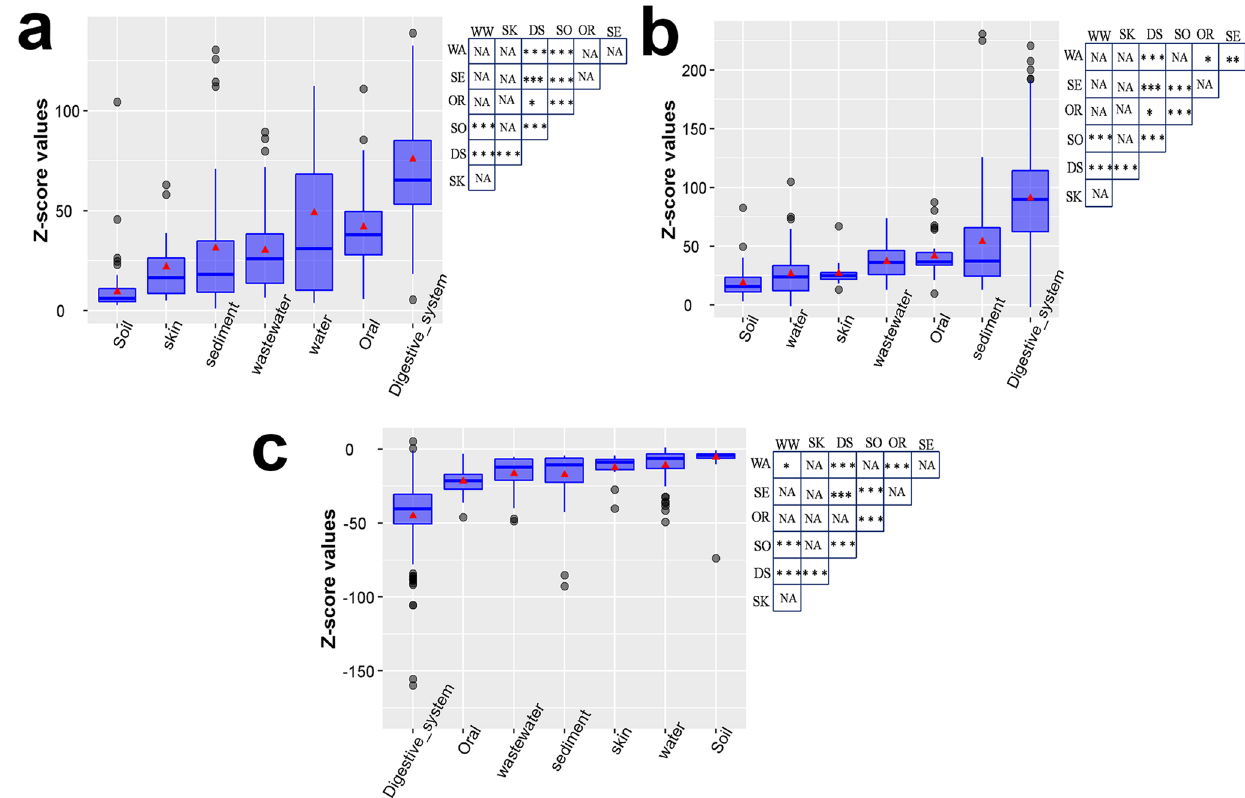
Fig. 4 Average Z-score for CAI, ENC, and DCBS values of samples from seven selected habitats. This fi gure shows the Z-scores calculated for three codon usage indices (CAI, ENC, and DCBS) of samples from each selected biome in the form of box plots. Panels a , b , and c represent Z-scores for CAI, DCBS, and ENC values respectively. Z-score values were calculated comparing average CAI/EN/DCBS values of real and random sequences of each sample. Each box represents Z-scores of samples derived from a speci fi c habitat. Horizontal line within a box represents the median value, whereas its upper and lower edges represent 25% and 75% of the data, respectively. The average of Z-scores of all samples from each habitat is shown with a red triangle. In each panel, niches were arranged from lower to higher average values of Z-scores. Statistical signi fi cance for pairwise comparison of average values (of codon usage indices) among the habitats was shown in adjacent panels. P -values were calculated by Wilcoxon signed-rank test and adjusted for multiple comparisons using Bonferroni correction. P -values for the pairwise comparisons are shown by abbreviating the group labels as WA-Water; SE-Sediment; OR-Oral; SO-Soil; DS-Digestive system; SK-Skin; WW-Wastewater. P -values *<0.05; **<0.01; ***< 1 ×10 − 6 . In each panel, boxes are arranged according to the median values of